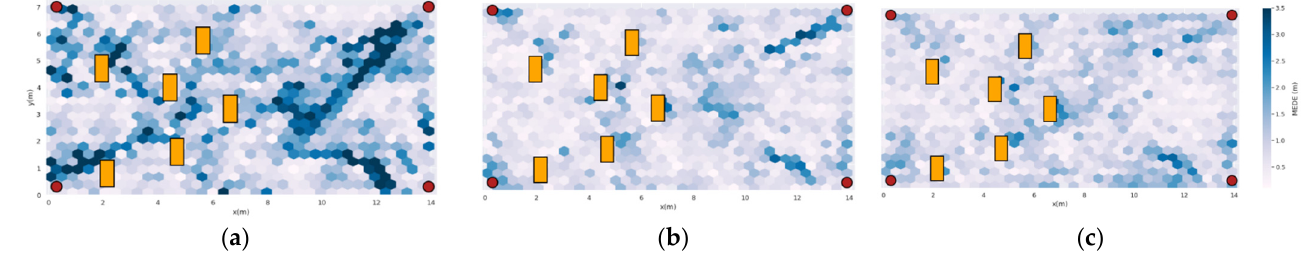
Figure 9. Spatial distribution of Euclidean error on the high furniture room of ( a ) PDDA; ( b ) CNN- based joint model; ( c ) pairs of APs Model.